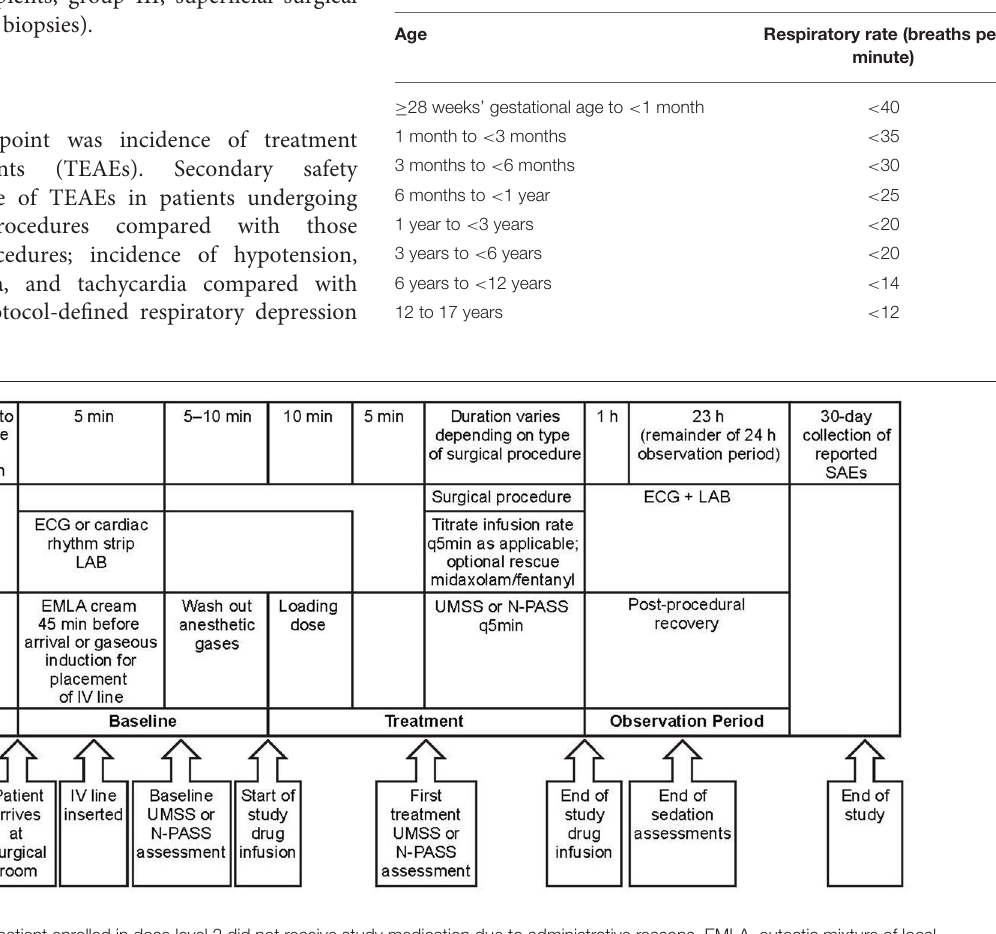
FIGURE 1 | Study design. One patient enrolled in dose level 2 did not receive study medication due to administrative reasons. EMLA, eutectic mixture of local anesthetics; ECG, electrocardiogram; IV, intravenous; LAB, laboratory assessment; N-PASS, Neonatal Pain, Agitation and Sedation Scale; q5 min, every 5 min; SAE, serious adverse event; UMSS, University of Michigan Sedation